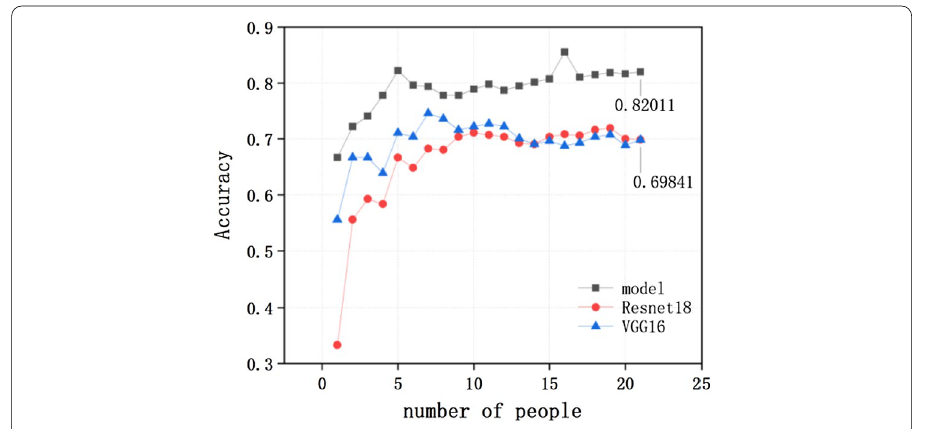
Fig. 17 The diagram of testing accuracy